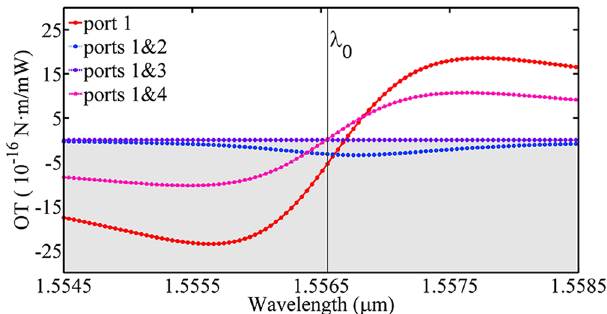
Figure 3. Optical torques with different double-port excitations.